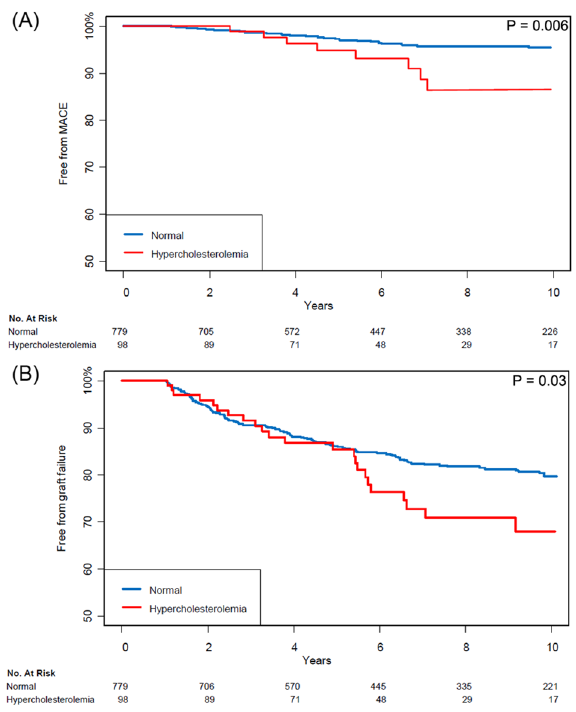
Figure 2. Kaplan–Meier curves of the normal and the hypercholesterolemia groups for ( A ) major adverse cardiac event and ( B ) graft failure.